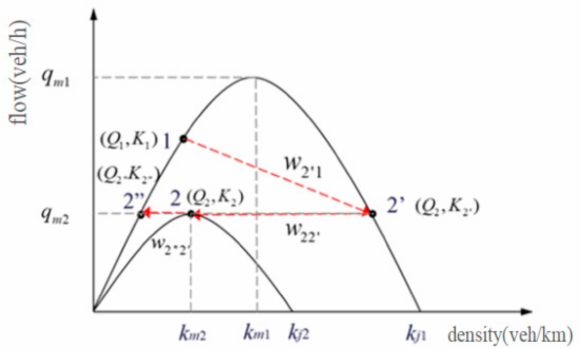
Figure 2. Flow–density following an accident in the extra-long tunnel.